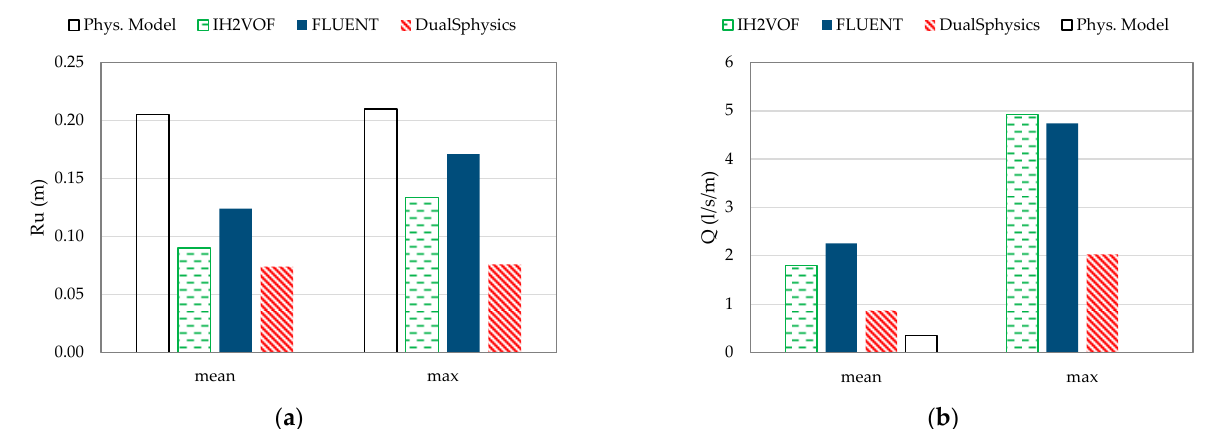
Figure 12. Mean and maximum wave run-up obtained for test 1 ( a ) and mean and maximum wave overtopping discharge obtained for test 5 ( b ).